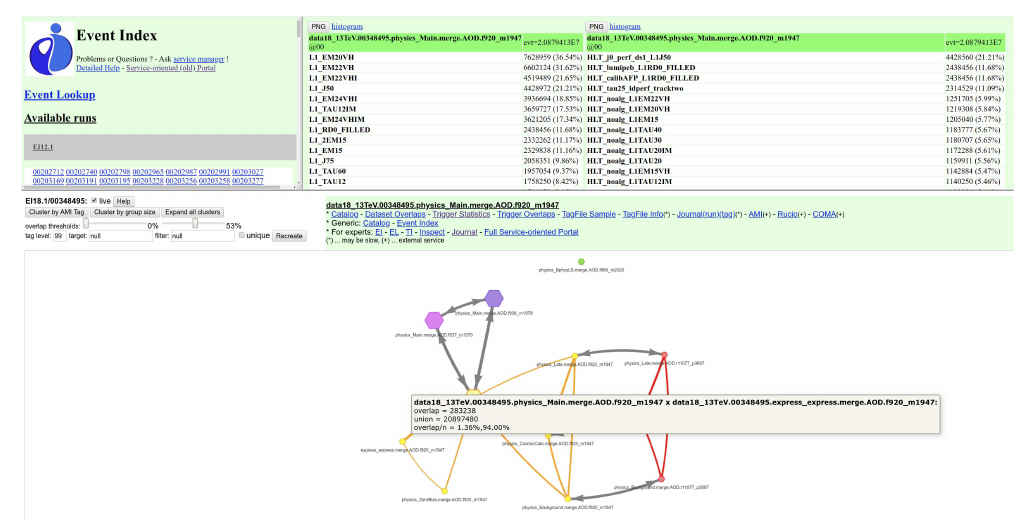
Figure 1. Data-oriented Graph Web